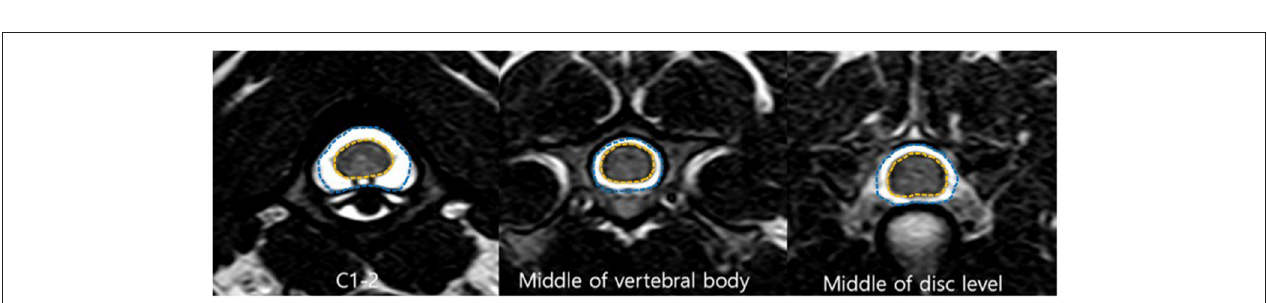
FIGURE 2 | Transverse T2-weighted magnetic resonance (MR) images. Cross-sectional area (CSA) of the spinal canal ( blue line ) and the spinal cord ( orange line ).